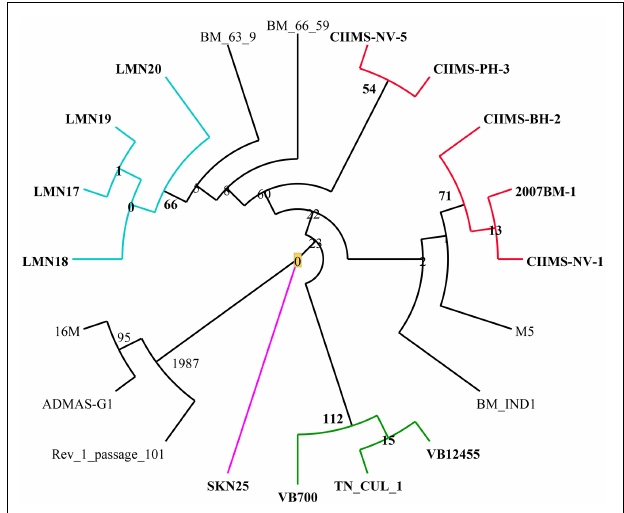
FIGURE 7 | SNP-based phylogeny. Most of the Indian isolates except ADMAS-G1 clustered together. Blue, red, green, and pink color branches indicate isolates from Punjab, Maharashtra, Tamil Nadu, and Gujarat, respectively. Numbers in each node represent the node SNPs.